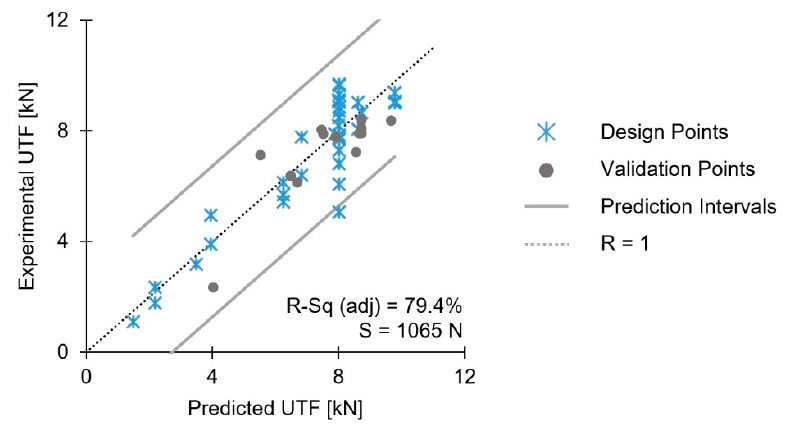
Figure 15. Validation diagram for the reduced model of UTF.